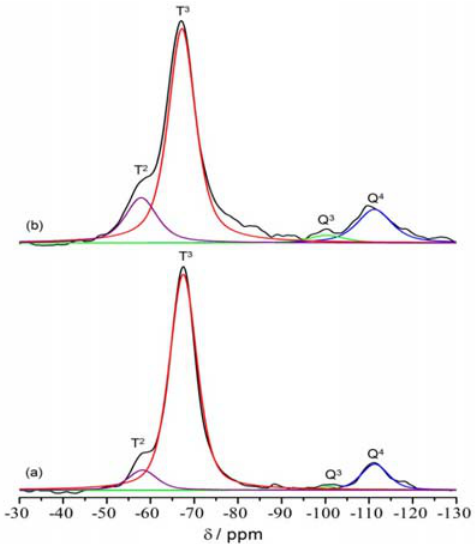
Figure 5. 29 Si MAS NMR spectra of ( a ) TIE(600)-32 and ( b ) TIE(600)-8 hybrid electrolytes. Different color lines represent the components used for spectral